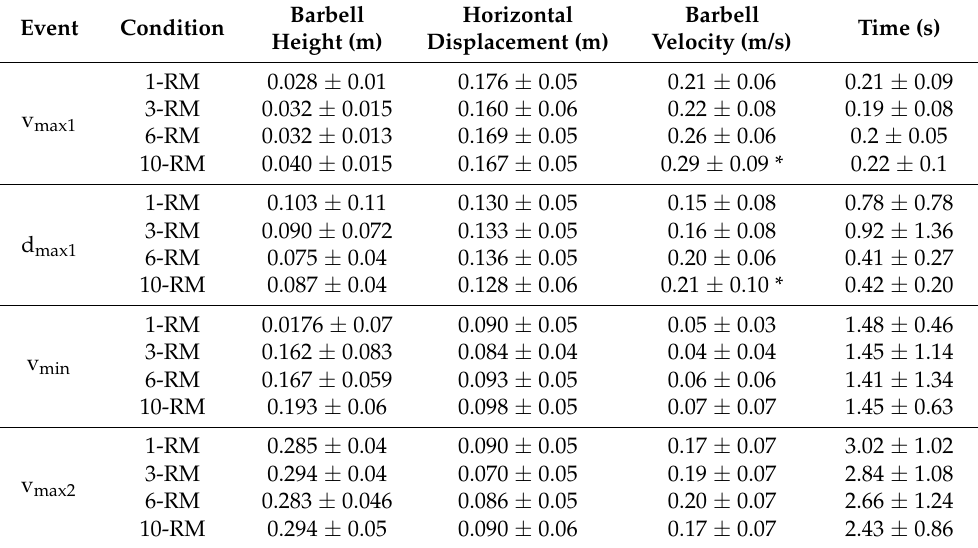
Table 1. Mean ± SD relative barbell height, barbell velocity, and time at different RMs at the events v max1 , v min , and v max2 during bench press. * p < 0.05. Event